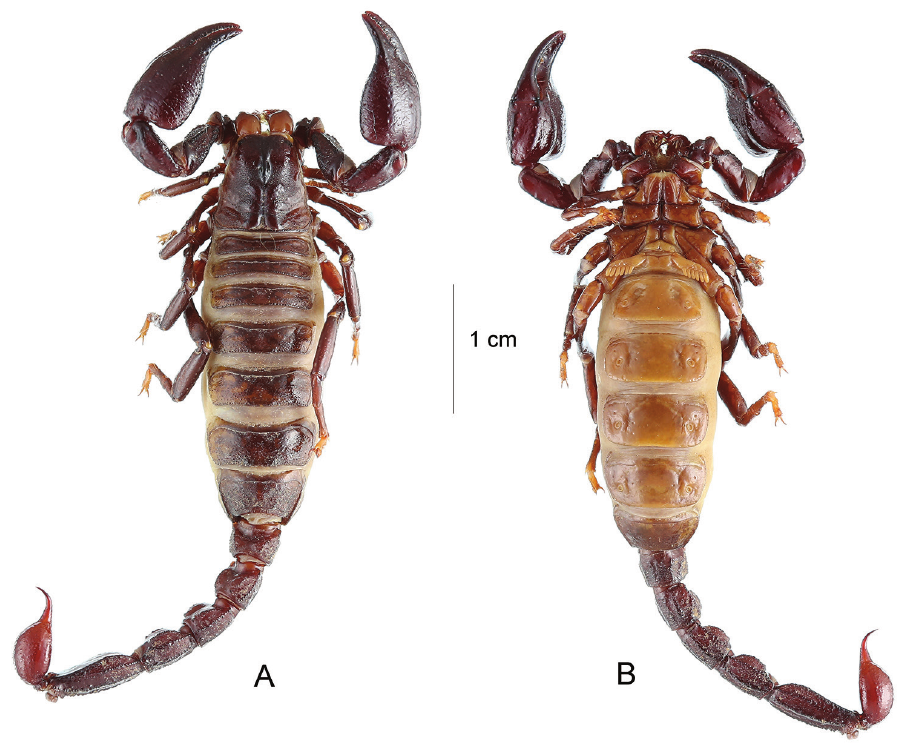
Figure 5. Teuthraustes giupponii sp. n. Female holotype. Habitus, dorsal A and ventral B aspects.